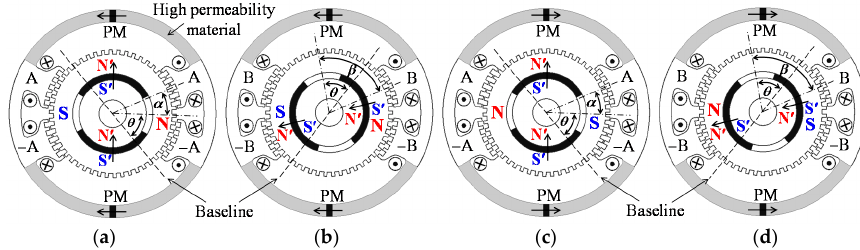
Figure 5. Accurate 2-D equivalent motor model of sub-motor1. ( a ) 2-D model of part I; ( b ) 2-D model of part II; ( c ) 2-D model of part III; ( d ) 2-D model of part IV.